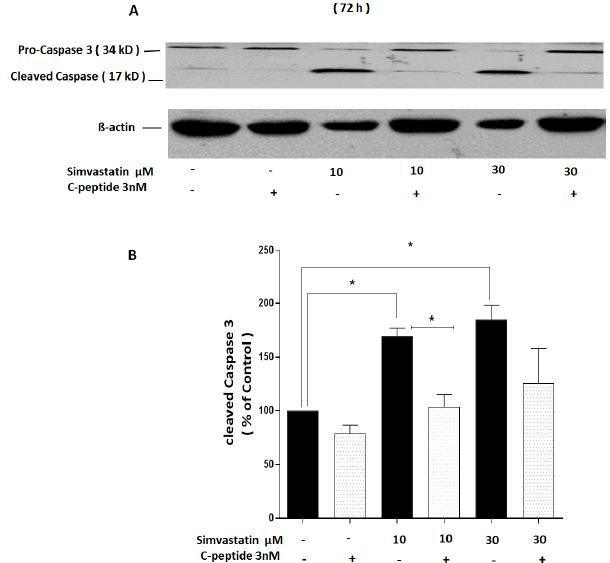
Figure 5. C-peptide blunts the effect of simvastatin–induced caspase-3 cleavage in L6 myoblasts. Cells were treated with 10 and 30 µ M simvastatin and co-treated with 3 nM rat C-peptide for 72 h. ( A ) Cleavage of caspase-3 was determined by the Western blot using specific anti-caspase-3 antibody. As a loading control, membranes were reprobed with antibody against β actin; ( B ) densitometry analysis of four experiments was performed at 72 h and data are presented as mean ± SEM.* p <